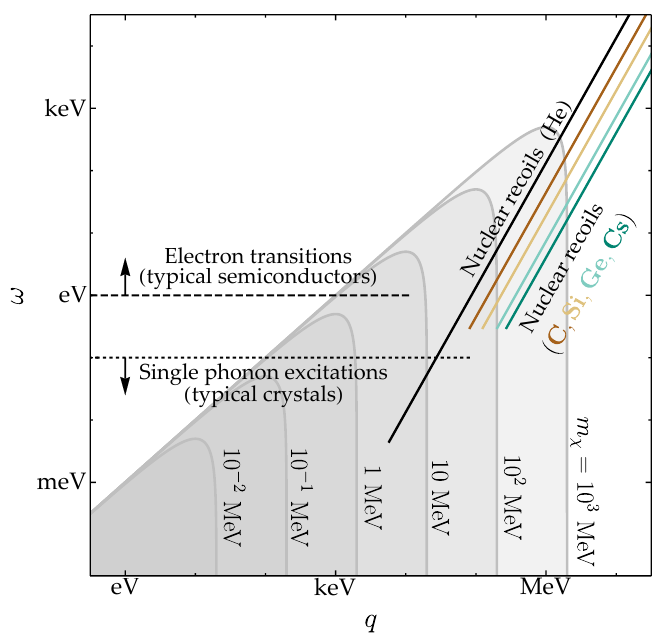
Figure 1 . Illustration of kinematic regimes probed via the three detection channels considered in this paper. For an incoming DM particle with velocity v = 10 (cid:0) 3 , the momentum transfer q and energy deposition ! are bounded by ! (cid:20) qv (cid:0) q 2 = 2 m (cid:31) , shown by the shaded regions for three DM masses. Nuclear recoils require ! = q 2 = 2 m N for a given type of nucleus, shown by the solid lines for helium and several elements in existing or proposed crystal targets. Standard calculations assuming scattering o(cid:11) individual nuclei break down below a few meV (a few hundred meV) for super(cid:13)uid He (crystal targets), where we truncate the lines. Electron transitions can be triggered for ! above the band gap, which is O (eV) for typical semiconductors, as shown by the dashed line. The end point at q (cid:24) 10 keV corresponds to a few times (cid:11)m e , above which valence electron wavefunctions are suppressed, and only (semi-)core electrons can contribute (which requires ! to be much higher than the band gap). Single phonon excitations are relevant for ! . O (100 meV) in typical crystals, as p shown by the dotted line. The momentum transfer can be up to q (cid:24) m N ! ph (cid:24) O (100 keV)